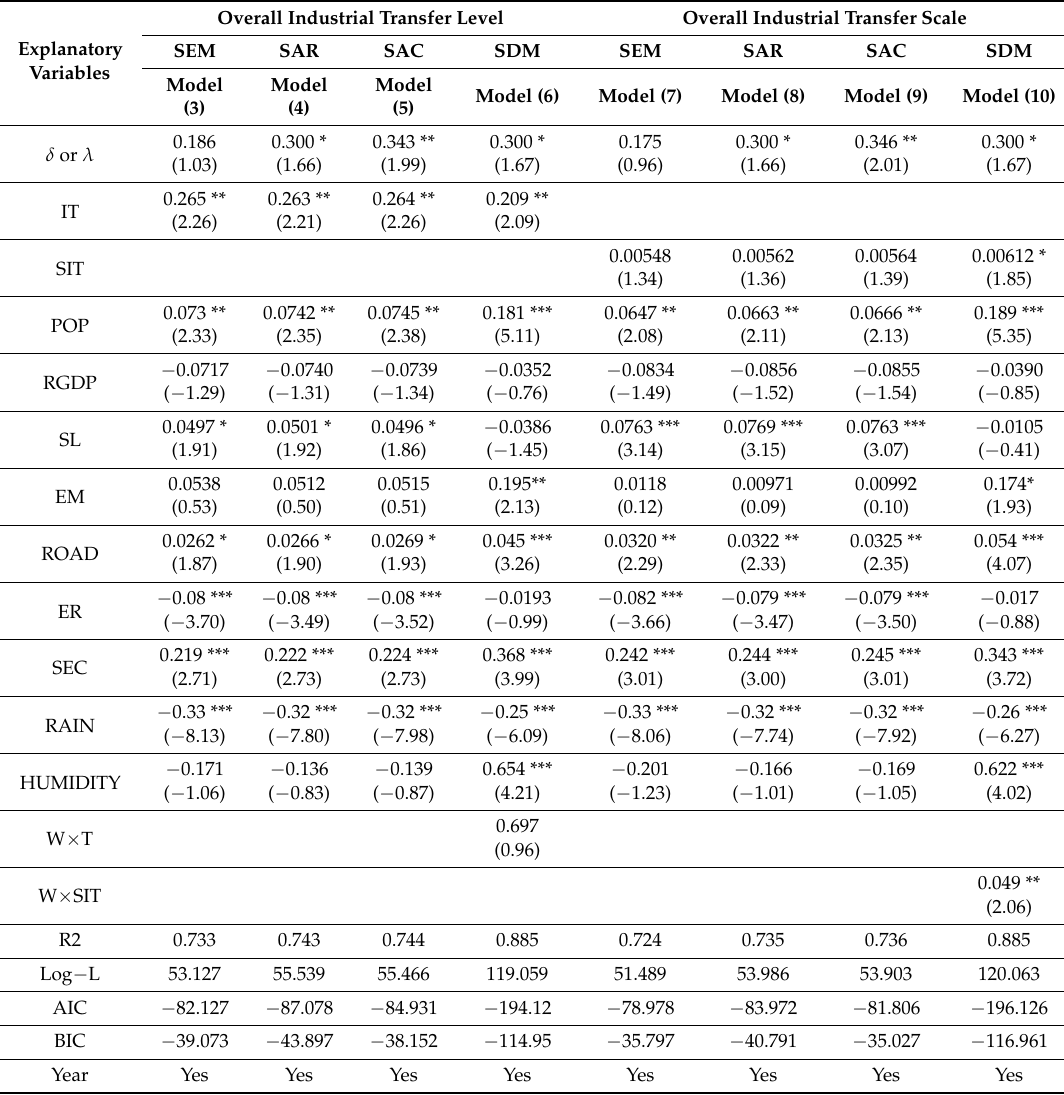
Table 6. Regression results of the impact of overall industrial transfer on haze pollution.